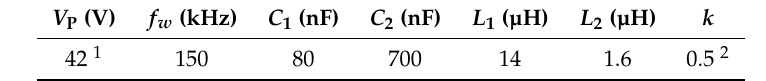
Table 1. Characteristic parameter values of the SS-ICPT prototype developed in this